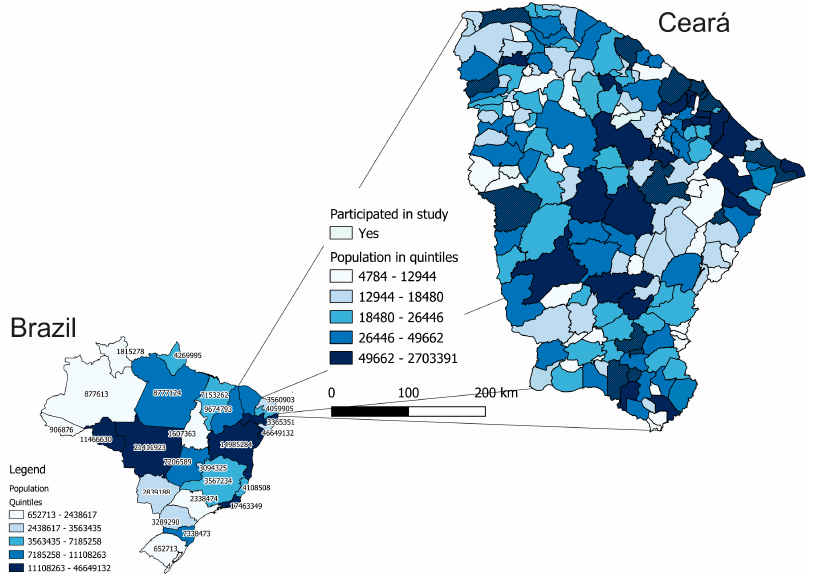
Figure 1. location of Ceará in northeastern Brazil, with representation of the number of inhabitants Figure 1. Location of Cear á in northeastern Brazil, with representation of the number of inhabitants by state (in Brazil) and by municipality (in Ceará). Municipalities participating in the Mais infancia by state (in Brazil) and by municipality (in Cear á ). Municipalities participating in the Mais infancia program are highlighted. program are